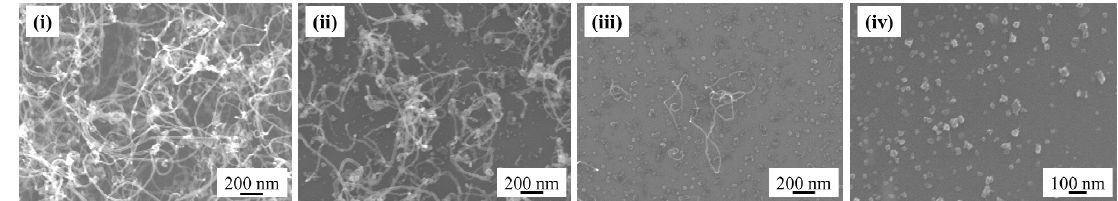
Figure 7 . The surface morphology after the PECVD with different nanoparticle: ( i ) Fe ( ii ) Fe 0.5 Mn 0.5 ( iii ) Fe 0.9 Mn 0.1 ( iv ) Mn. The composition ratio is evaluated based on Vegard’s law.